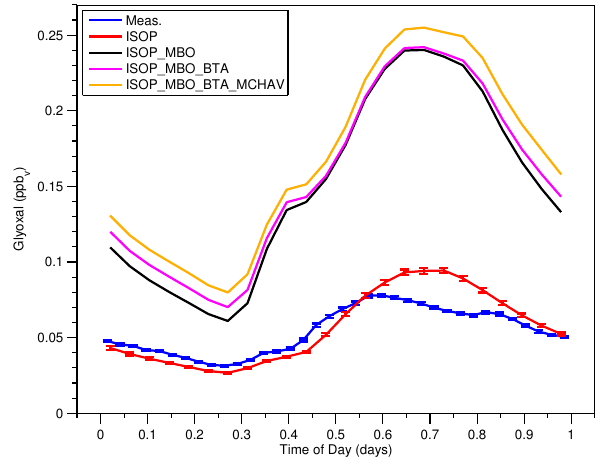
Fig. 4. Diurnally averaged model results from the hot period showing the incremental contributions of various VOC precursors. The model VOC precursor subsets correspond to: ISOP=isoprene; MBO=MBO; BTA=benzene, toluene, acetylene, and pinenes; MCHAV=methylchavicol. Error bars are omitted from upper traces for clarity, all are approximately equal in magnitude to those shown for that of ISOP. The form and magnitude of MBO alone is similar to that of ISOP + MBO.